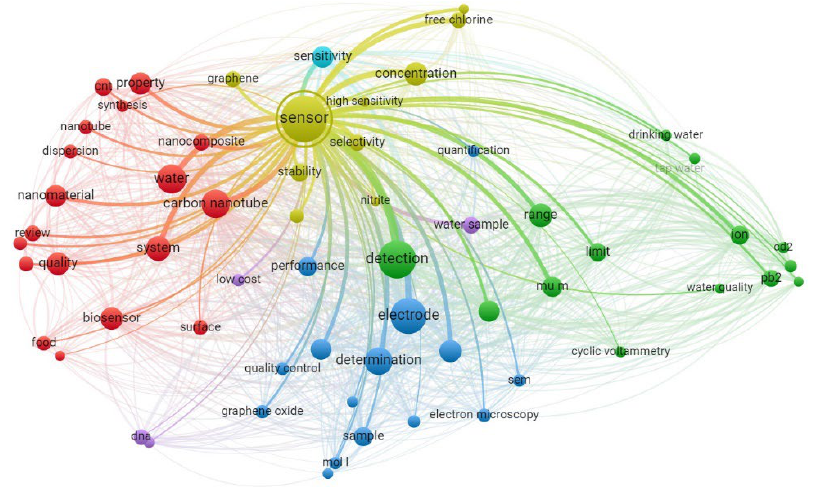
Figure 8. Cluster 4 Network—“sensor” main keyword. Table 7. Cluster 4 keywords and occurrences.